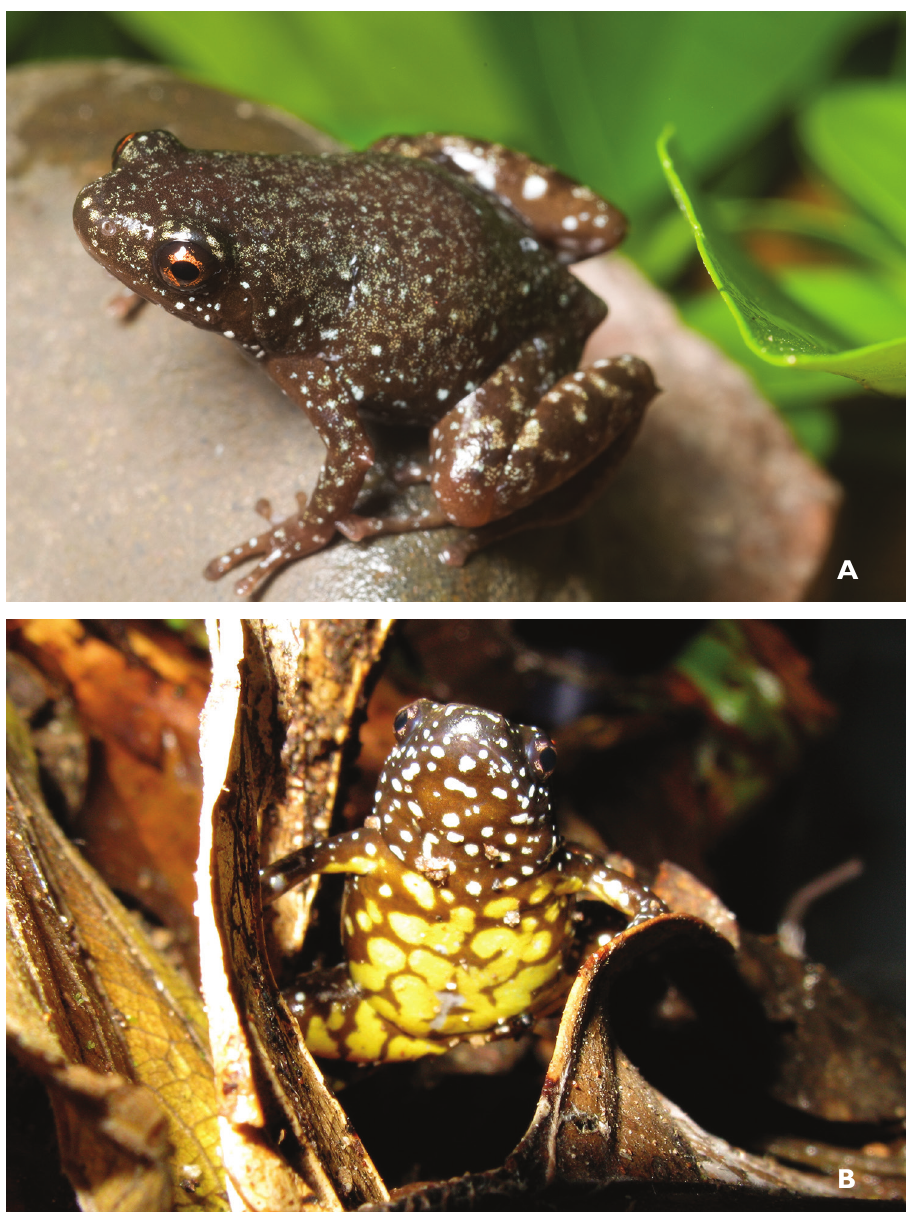
Figure 19. Chaperina fusca female ( A KU 321410) from Barangay Tulosa, Pasonanca Natural Park, Zamboanga City Province, Mindanao Island. Photo: RMB; ( B KU 319441.) male from 1900 masl, Mt. Balatukan, Municipality of Gingoog, Misamis Oriental Province. Photo: ACD.